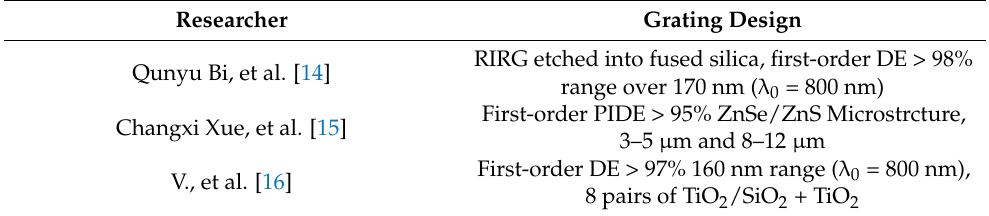
Table 1. Research on the design of dielectric gratings in recent